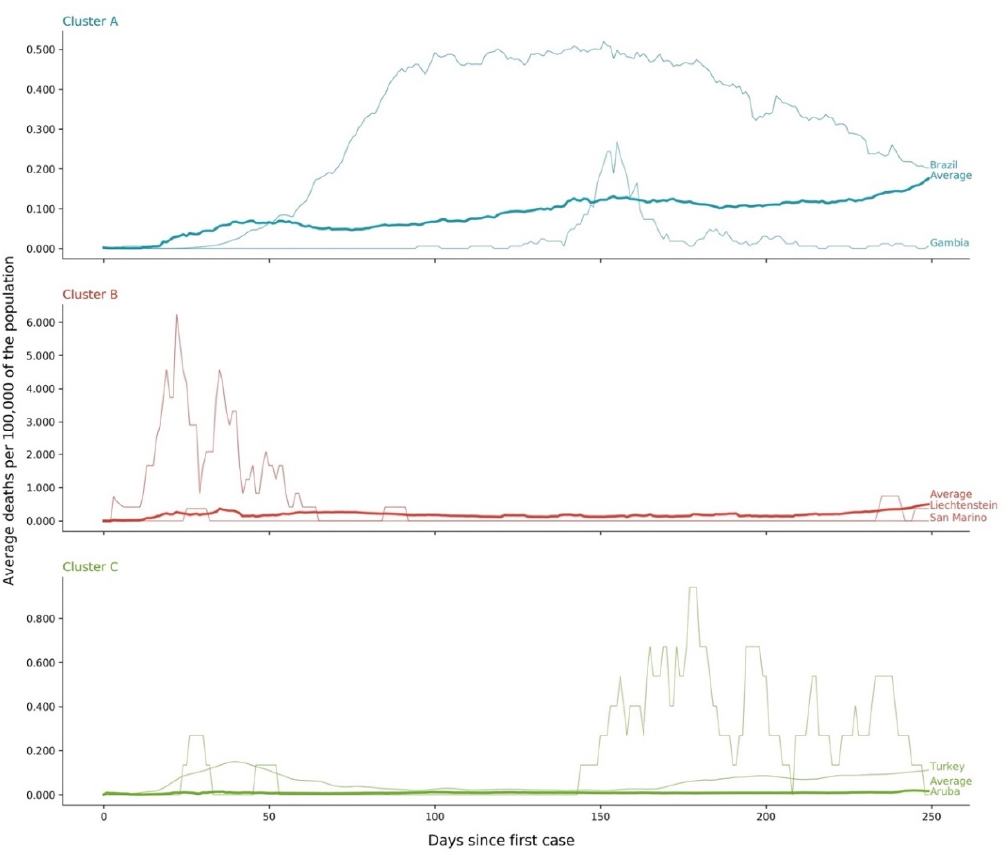
Figure 11. Seven-day moving average of deaths per 100,000 people in each cluster (also with time series of countries with minimum and maximum accumulated deaths by 100,000 of the population at Day 250).